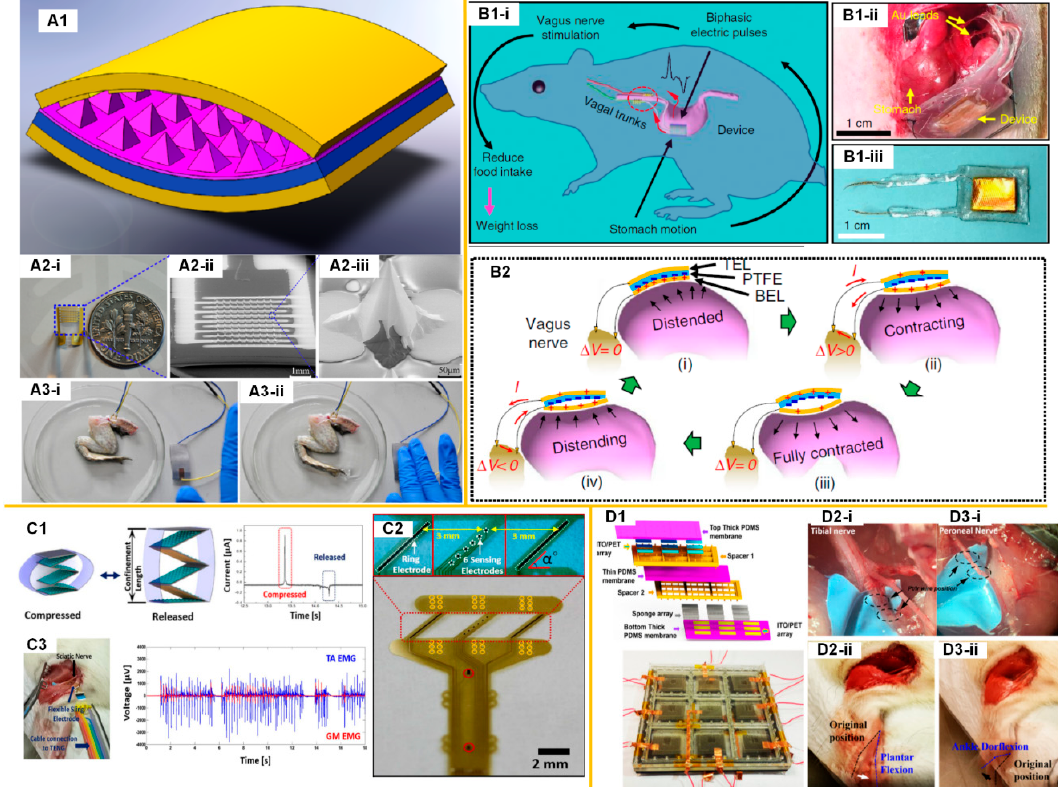
Figure 1. Triboelectric nanogenerator (TENG)-based nerve stimulations. ( A ) The stimulation of a